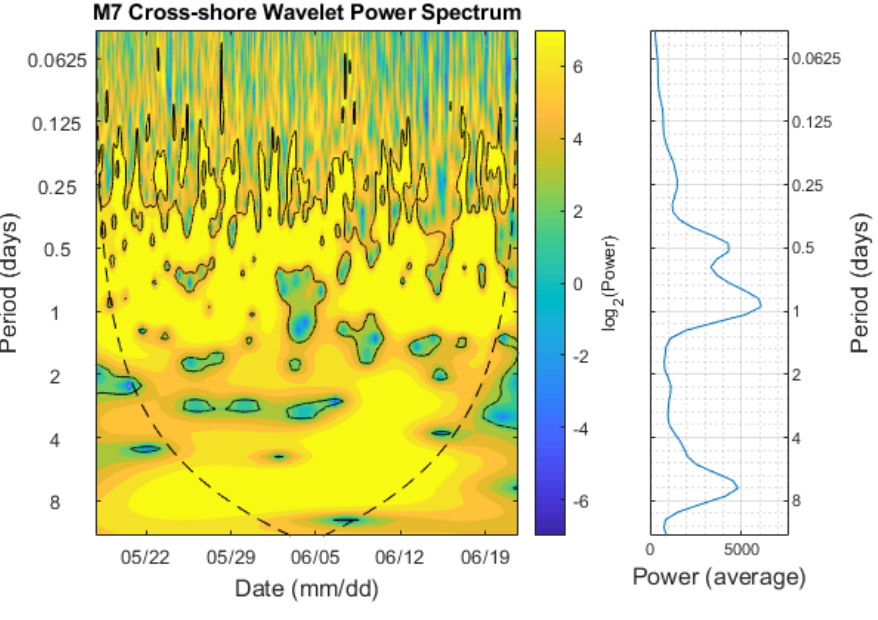
Figure 8. ( a ) Locations of the bottom current meters off the Texas coast. Grey lines show isobaths at 50 m intervals, with darker lines at 250 m intervals. Blue arrows indicate the mean flow. ( b ) Wavelet analysis at location M7 of the cross-shore current component with (left) the power spectrum as a function of time and (right) the global power spectrum. The solid black contour indicates where power becomes significant. The dashed line indicates the cone of influence, where anything “below” is potentially affected by edge